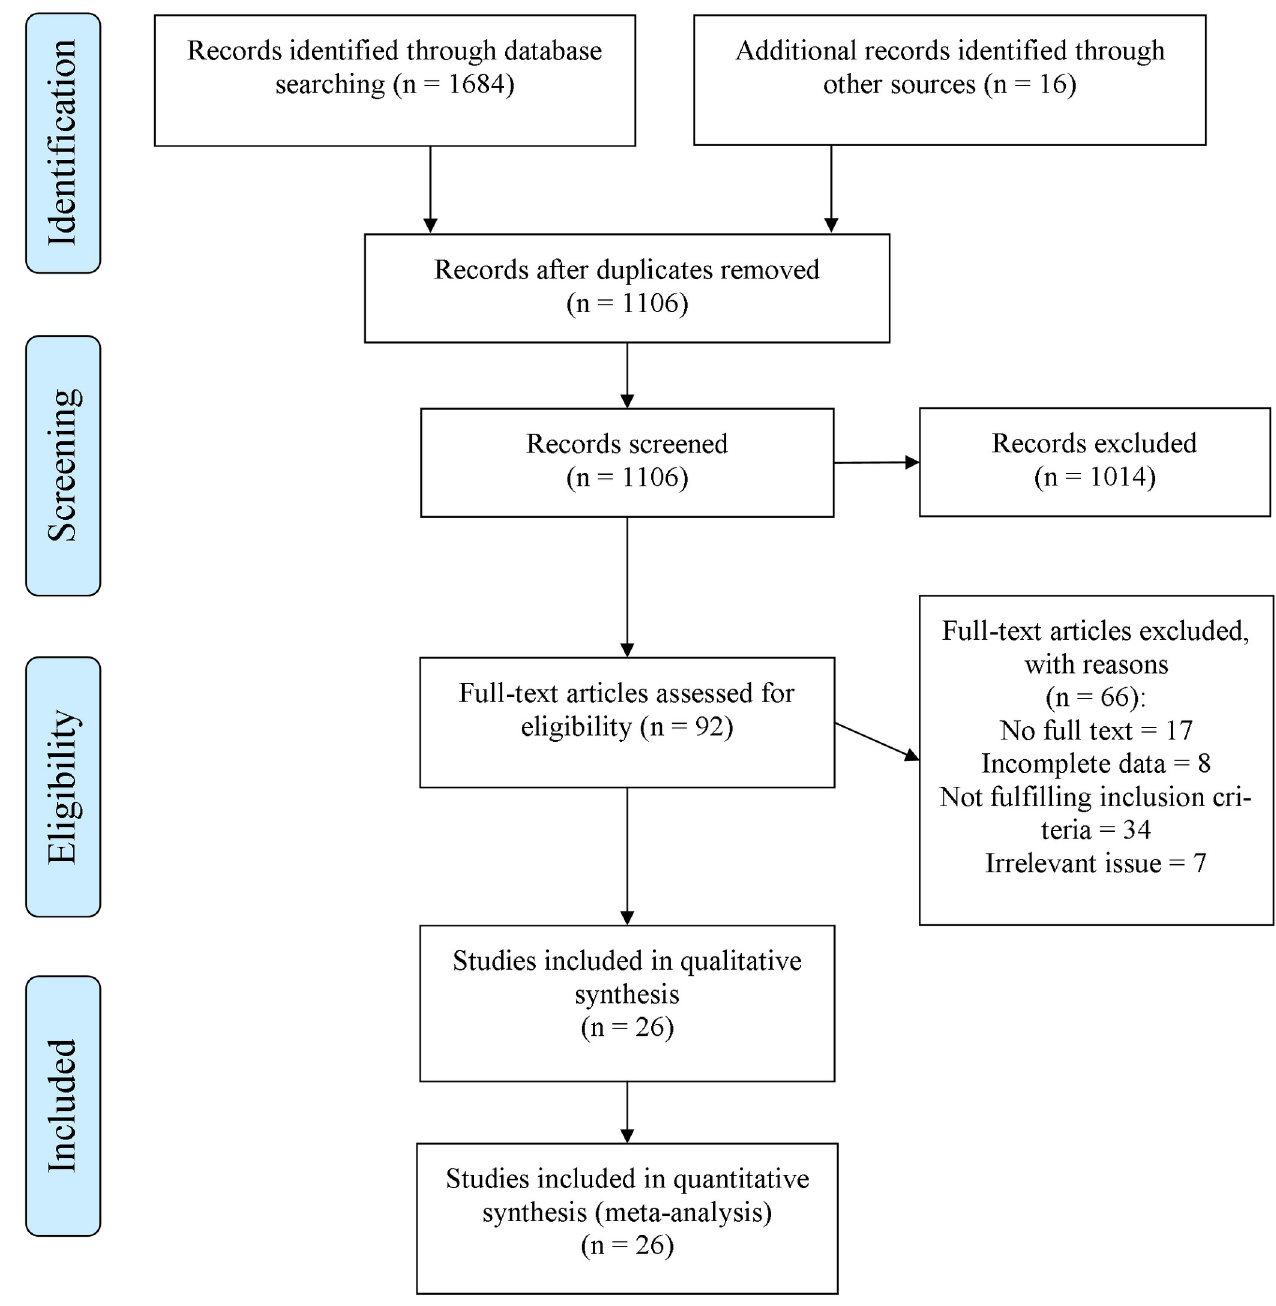
Fig 1. Flow diagram of literature search, screening, and selection of studies for review and meta-analysis.